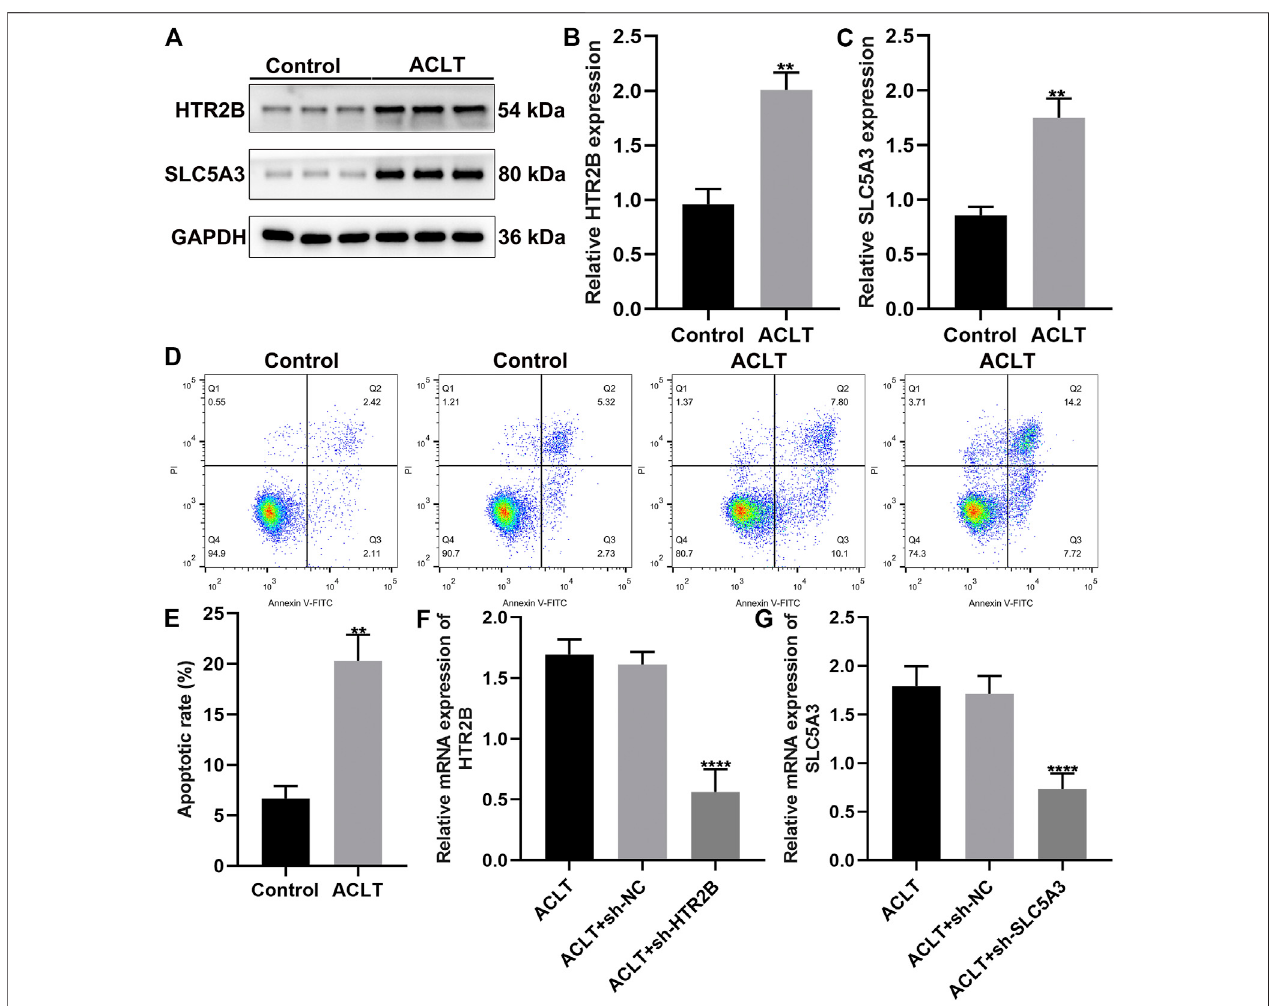
FIGURE7| Up-regulationofHTR2BandSLC5A3insynovialcellsofOArats. (A – C) Westernbotfordetectionoftheexpression ofHTR2Band SLC5A3proteins in synovial cells from sham-operation control and OA rats. (D,E) Flow cytometry for the apoptotic levels of control and OA synovial cells. (F,G) RT-qPCR for examining the mRNA expression of HTR2B and SLC5A3 in OA synovial cells transfected with sh-HTR2B or sh-SLC5A3. ** p < 0.01; **** p < 0.0001.